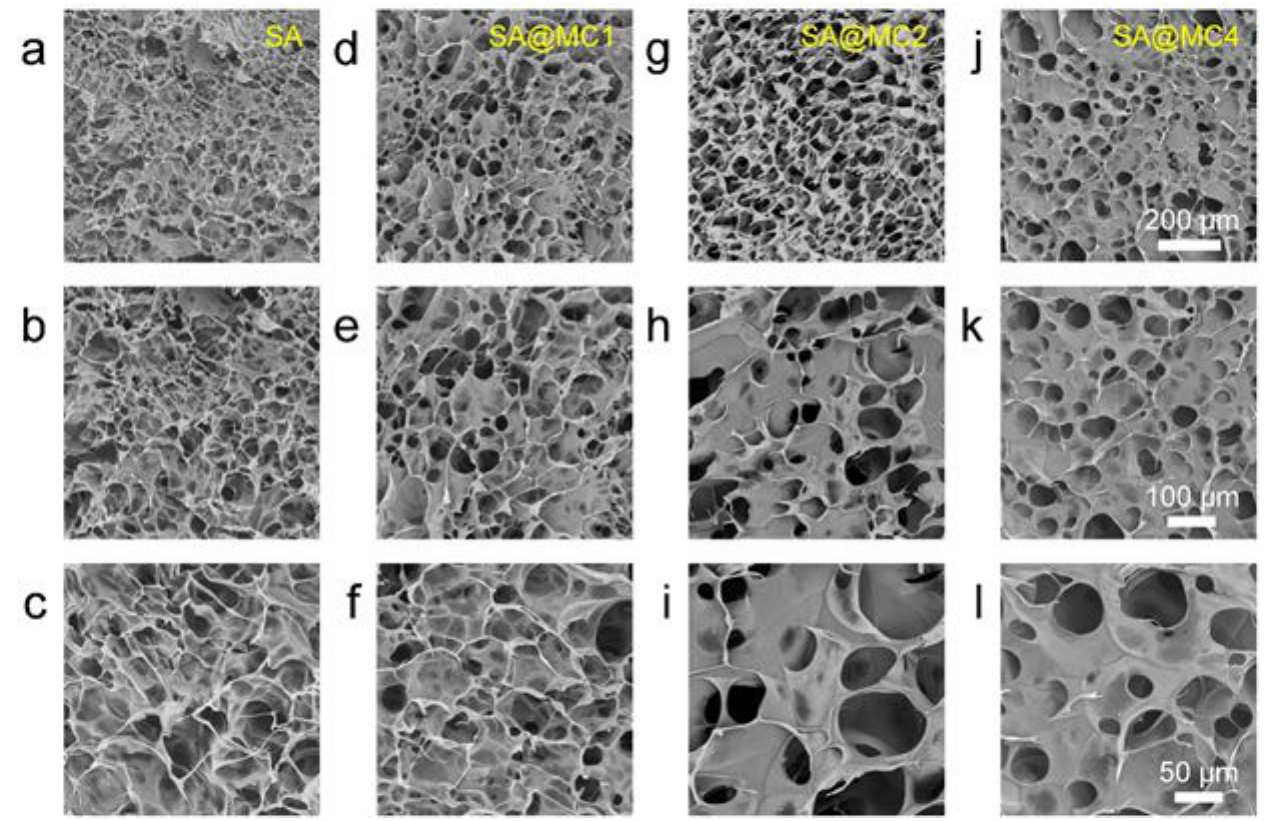
Figure 2. Microstructure of SA@MC hydrogels. ( a – c ) SA hydrogel; ( d – f ) SA@MC1 hydrogel; ( g –i) SA@MC2 hydrogel; ( j – l ) SA@MC4